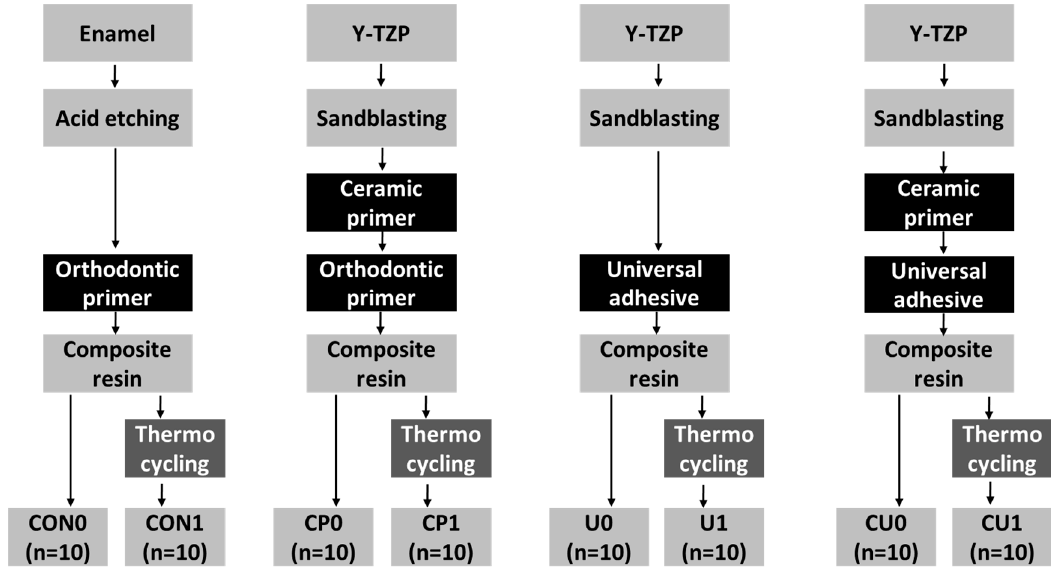
Figure 1. Flow chart of the experiment.